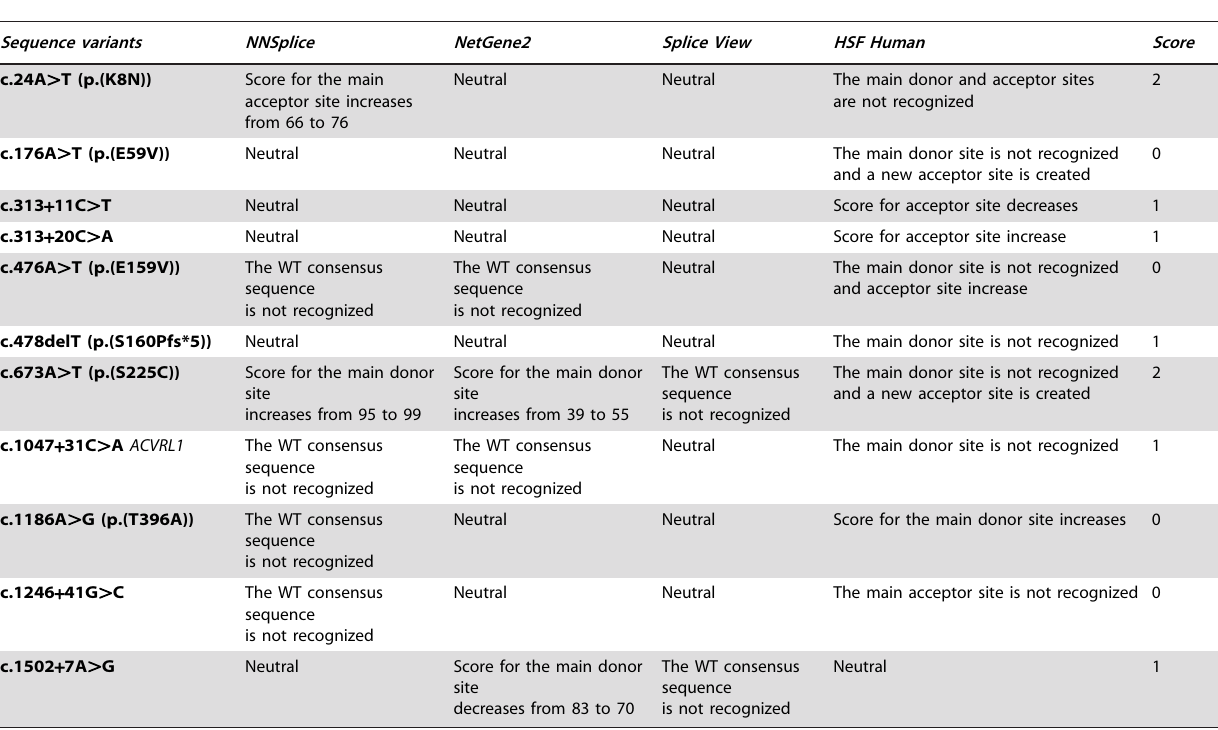
These results are considered positive if the score is equal or greater than two. doi:10.1371/journal.pone.0100261.t004 PLOS ONE |